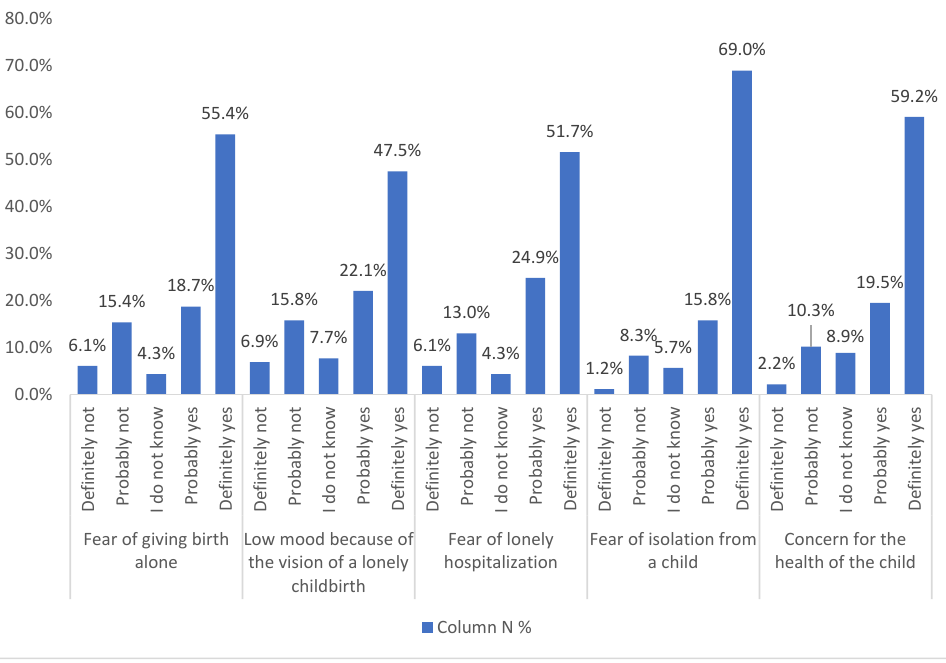
Figure 2. Emotions related with pregnancy ( n = 507).